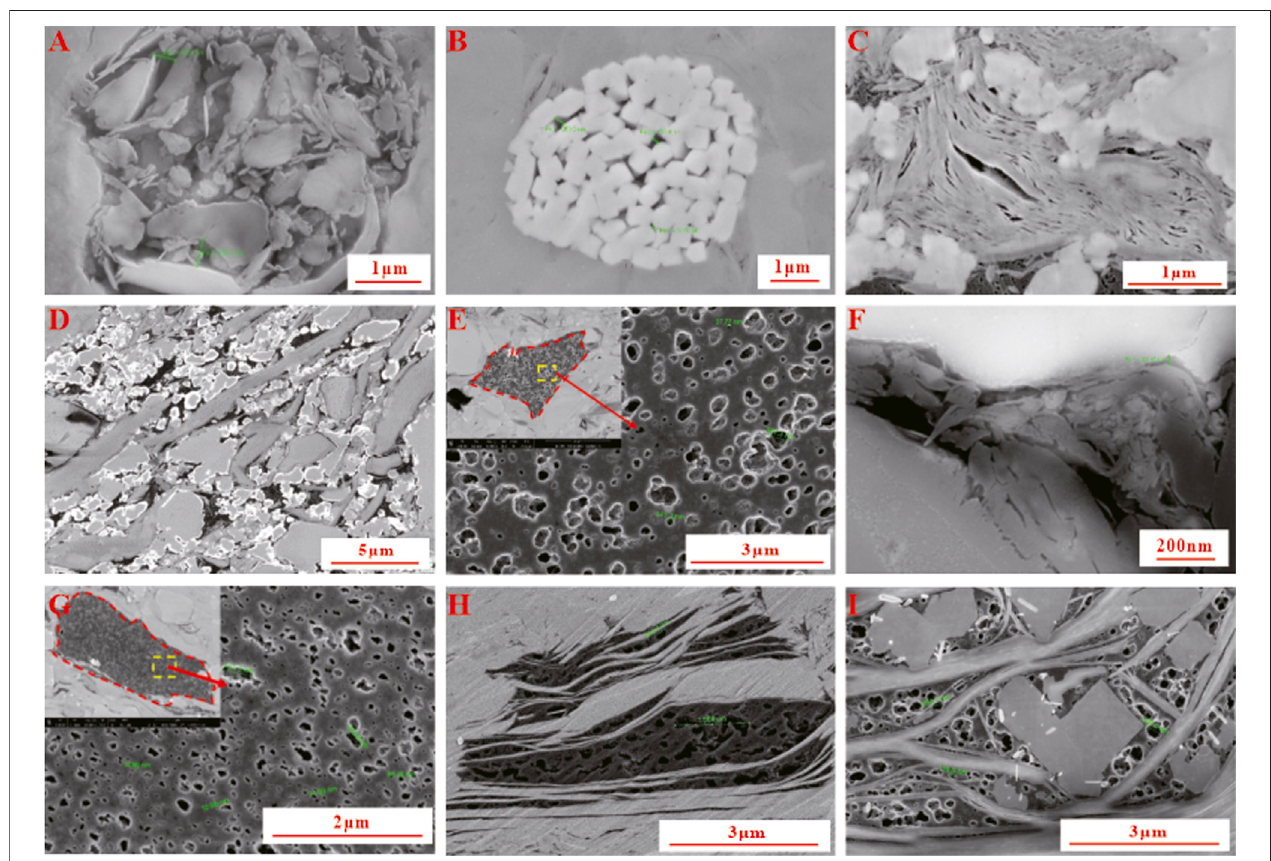
FIGURE 1 | Different storage space types in organic-rich shale (A) interparticle dissolution pores between clay minerals; (B) intercrystal pore of pyrite; (C) linear micropores between bedded clay mineral; (D) interparticle pores between quartzes; (E) isolated organic pores; (F) pores and fractures between clay minerals and organic matter; (G) partially connected pores; (H) elliptical and fl attened pores; (I) circular organic pore.